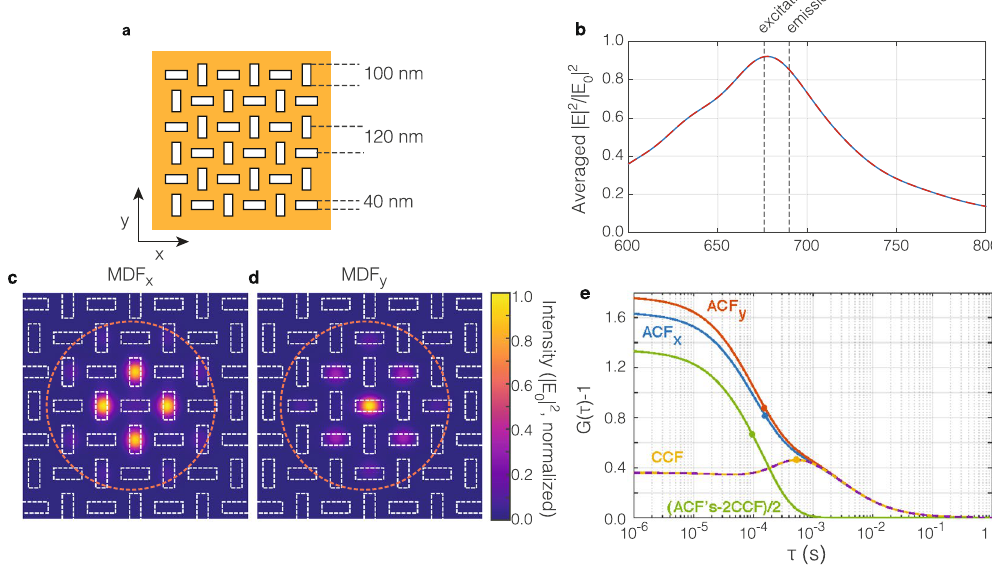
Figure 3. Periodic arrays of plasmonic nano-apertures for fluorescence correlation spectroscopy. ( a ) Sketch of an array of nano-apertures on a square grid with pitch d = 120 nm. The apertures alternate in orientation and measure 100 by 40 nm. The apertures are assumed located in a 100 nm thick gold film on glass, immersed in water. ( b ) For both x - and y -polarized incident light, the near-field in a plane 30 nm above the film (averaged over unit cell) shows a peak at 670 nm. ( c , d ) The calculated MDF’s for unpolarized excitation at 670 nm, and x – and y – polarized detection, assuming Gaussian beam optics with an NA of 0.7. The focused beam waist is shown with a dashed orange circle, and the 100 × 40 nm apertures are outlined on top of the color maps in white. Importantly, the MDFs are localized on subsets of differently oriented holes. ( e ) The autocorrelation functions for the intensity measured by the x - and y -polarized detectors (blue and red curves), the predicted cross-correlation between polarization channels (yellow and dashed purple curves), and autocorrelation of the polarization contrast (green, calculated as ( ACF x + ACF y − 2 CCF )/2). The spatial overlap of the two MDF s is sufficiently small that the cross-correlation shows a distinct maximum at 0.53 ms. The dots depict the roll-off time where the correlation has dropped to 50% of its maximum value (ACF), resp. the CCF peak